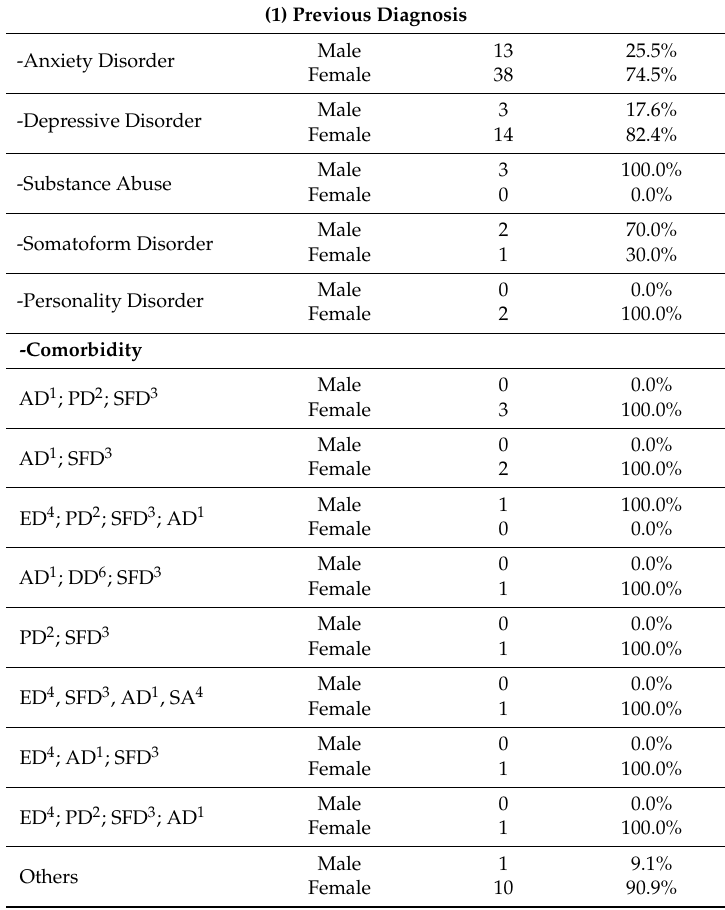
Table 3. Psychiatric comorbidity in patients with